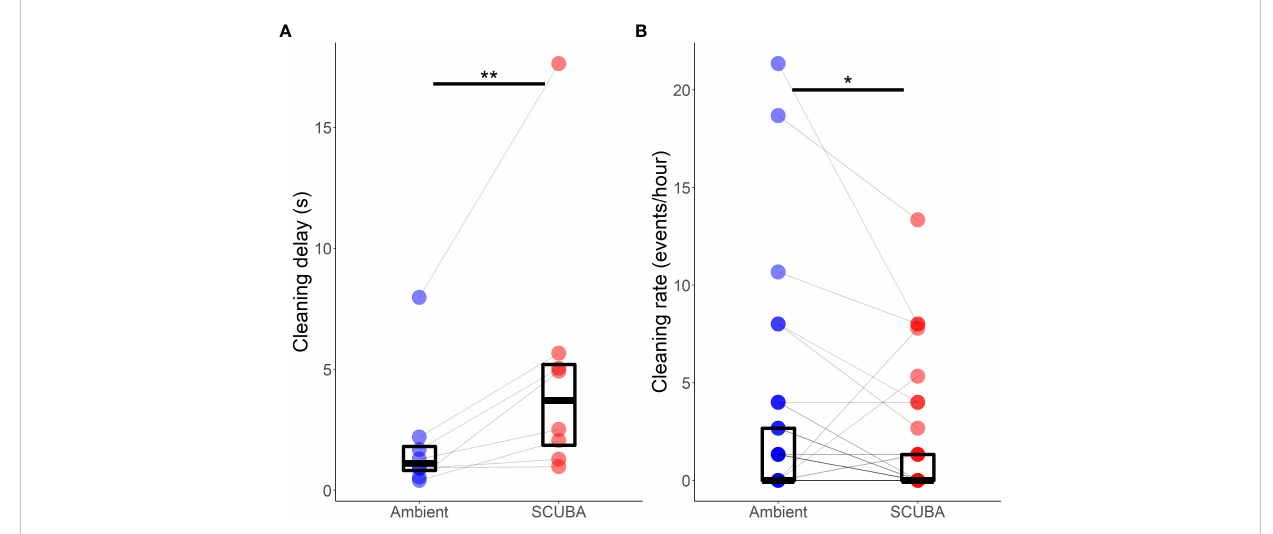
FIGURE 6 Difference in Ancylomenes pedersoni (A) delay to initiate cleaning and (B) cleaning rate between the two acoustic treatments (playback of ambient sound or SCUBA noise). Boxes show median and interquartile range; coloured points show data from individual cleaning stations; grey lines join paired data from the same cleaning stations. * p < 0.05, ** p < 0.01. N = 8 cleaning stations for (A) ; and n = 22 cleaning stations for (B)